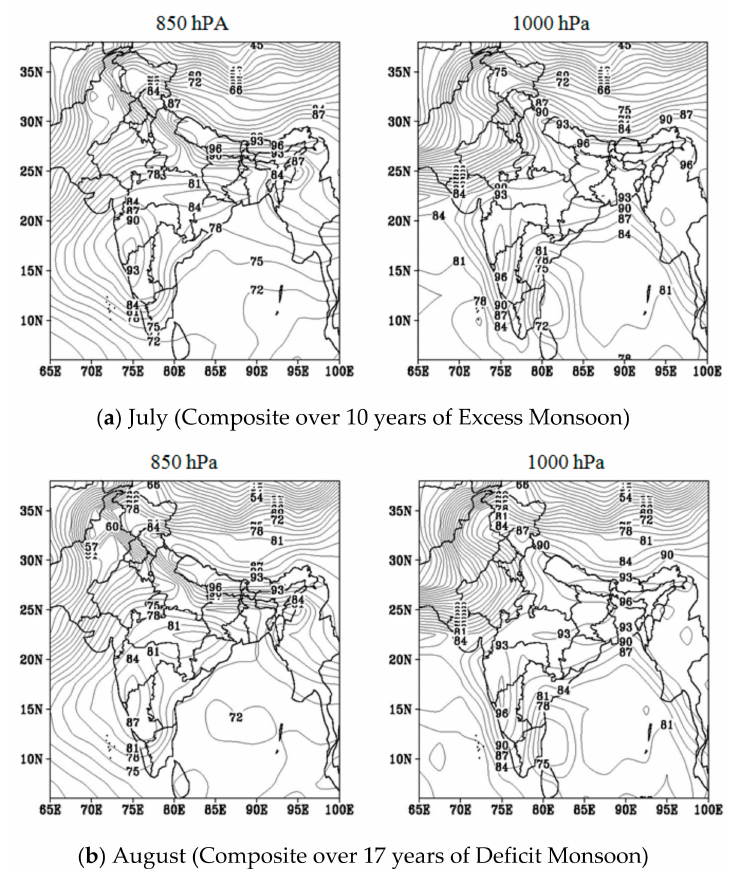
Figure 7. Composite climatology of humidity using NCEP reanalysis for the month of July ( a ) and August ( b ) at 850 hPa ( left ) and 1000 hPa ( right ) levels. The July (August) analyses are composited over excess (deficit) monsoon